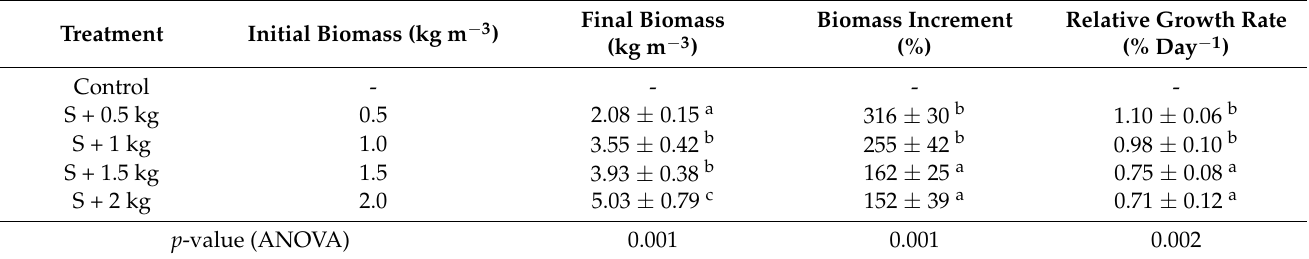
Table 3. The growth rate of sea grape integrated with whiteleg shrimp after 56 days of culture.